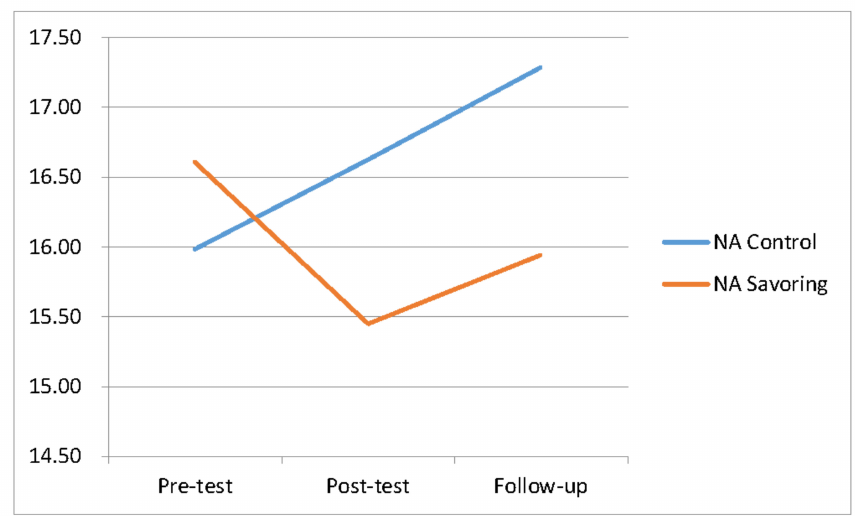
Figure 3. Changes in original mean score of NA during di ff erent stages.